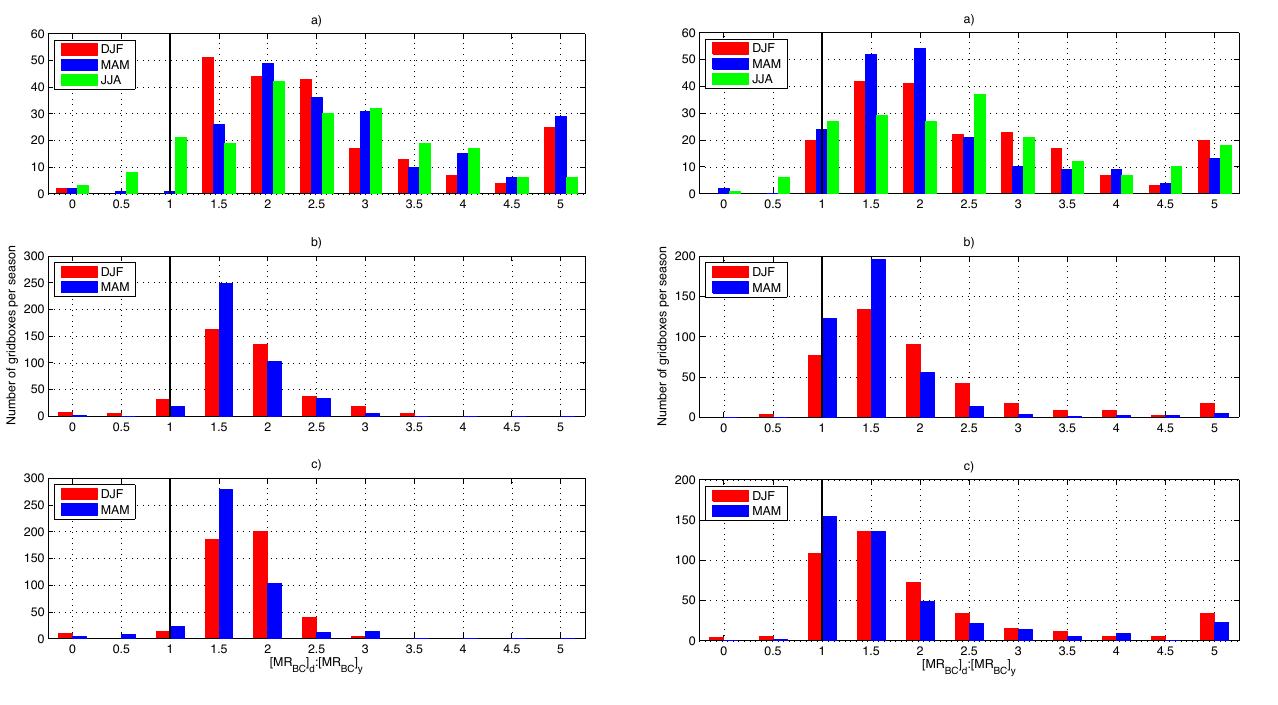
Figure 5. As in Fig. 4, but for offline calculations using the CRU/NCEP reanalysis SWE snowfall data to calculate MR BC,snowfall and therefore [MR BC ] d :[MR BC ] y